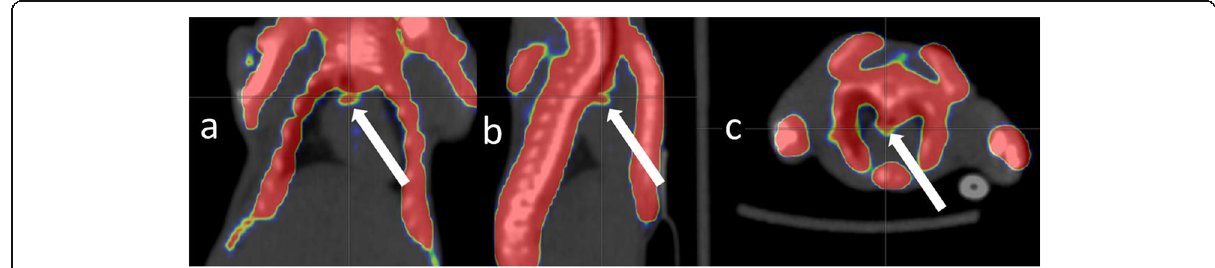
Fig. 4 Aortic [18F]NaF uptake in an uremic ApoE − / − mouse. [18F]NaF PET-CT acquired from 50 to 60 min after the injection of 26 MBq of [18F]NaF